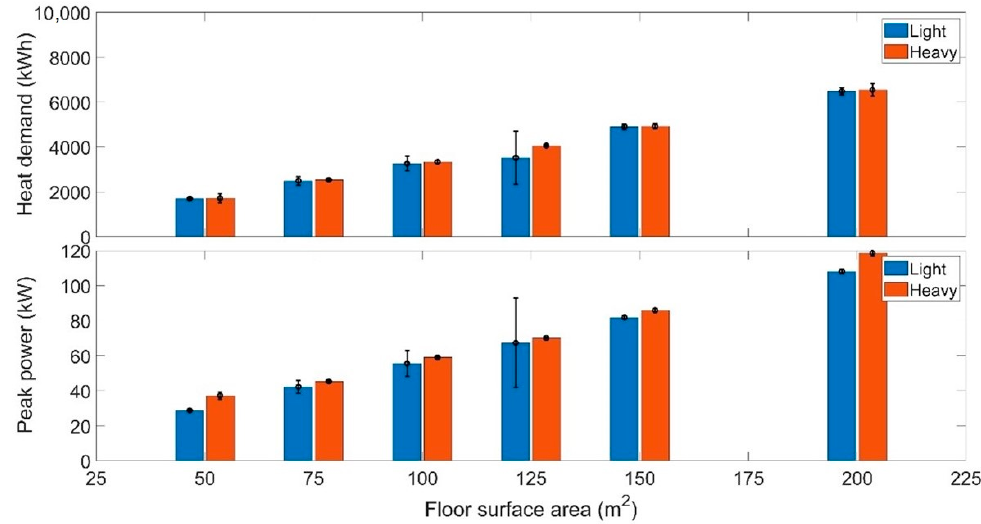
Figure 6. Distribution of total heat demand and maximum peak power around the average values for heavy- and light-structured buildings with respect to their surface area variations (results for 1000 h of simulation).